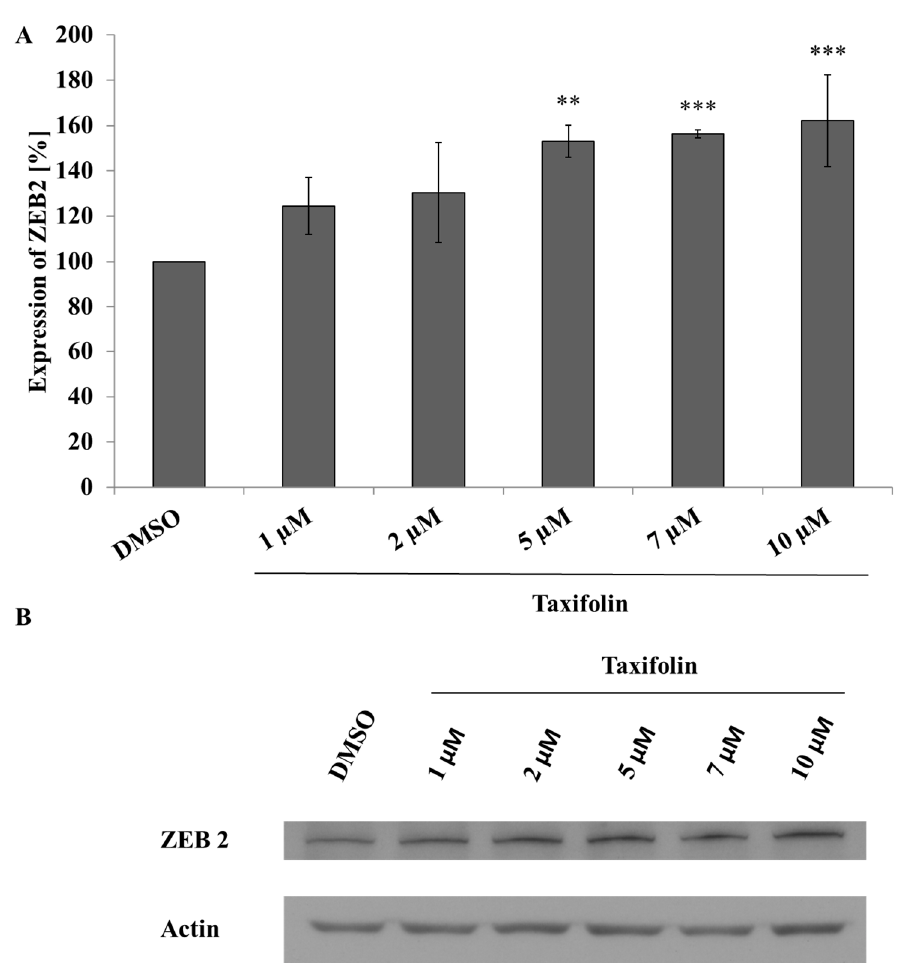
Figure 2. Modulation of ZEB2 expression by taxifolin in Hep G2 cells. Panel ( A ): Hep G2 cells were seeded and incubated with different concentrations of taxifolin. Negative control contains only dimethyl sulfoxide (DMSO). ZEB2 expression was evaluated by Western blot after 24 h of incubation. Each bar represents mean ±SD of three independent experiments. Panel ( B ): representative Western blot. ** p < 0.01(*** p < 0.001) versus negative control.